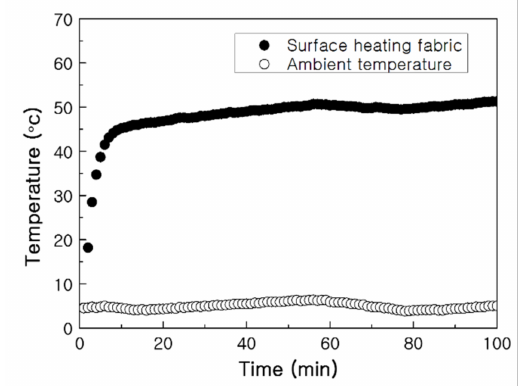
Figure 17. Heating behavior of the PTC-SHT at an applied voltage of 5 V from an initial temperature of 5 ◦ C.